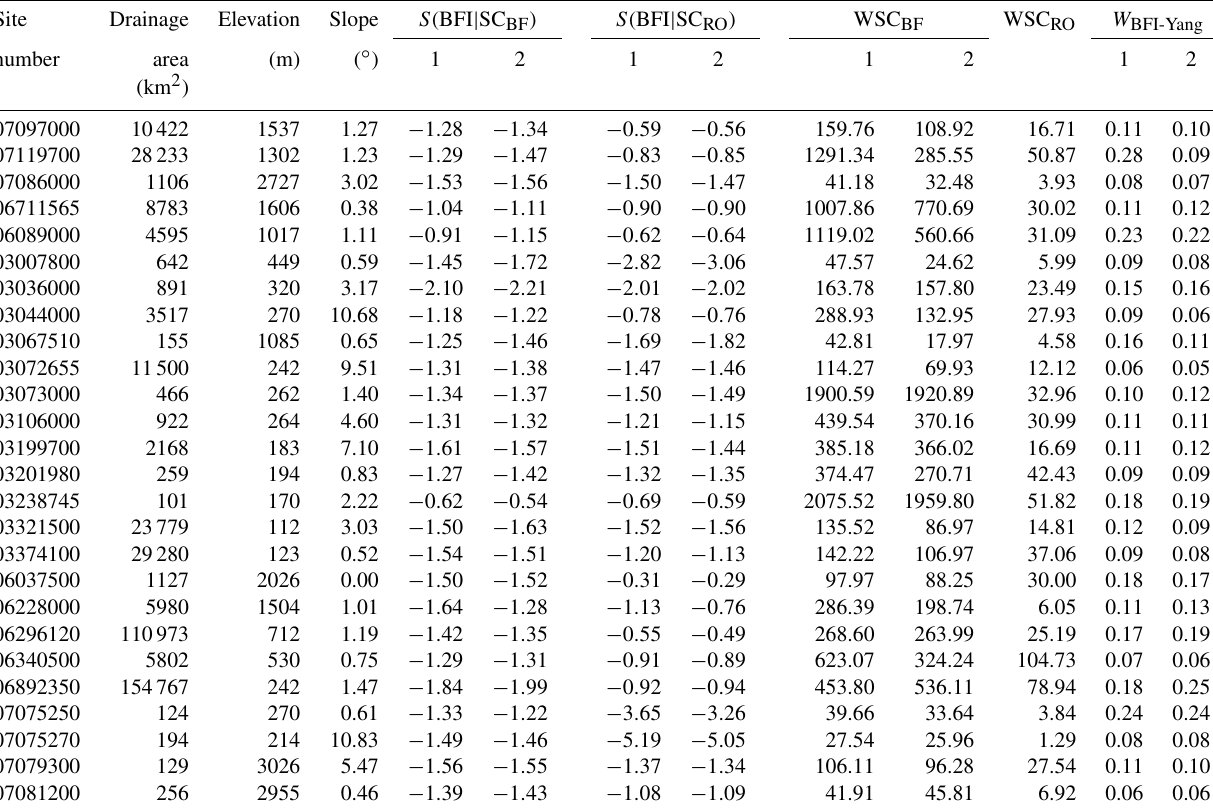
Table 1. A comparison of results for different methods used to obtain parameters for baseflow separation methods.